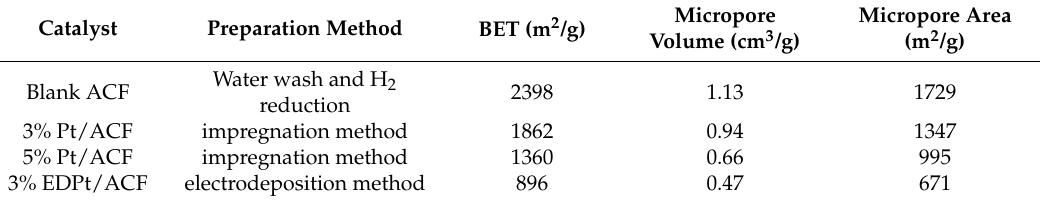
Table 1. Structural parameters of blank ACF and the